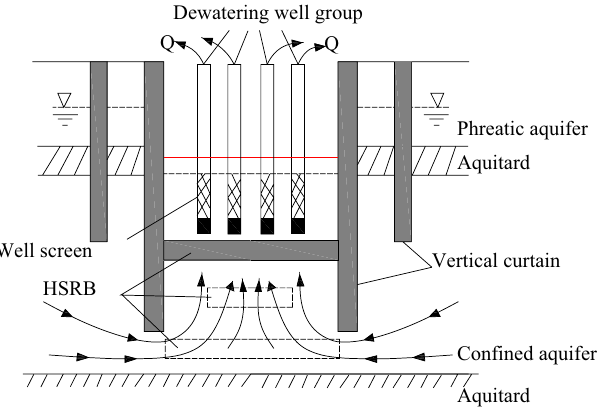
Figure 16. Conceptual model of three-dimensional curtain-well group